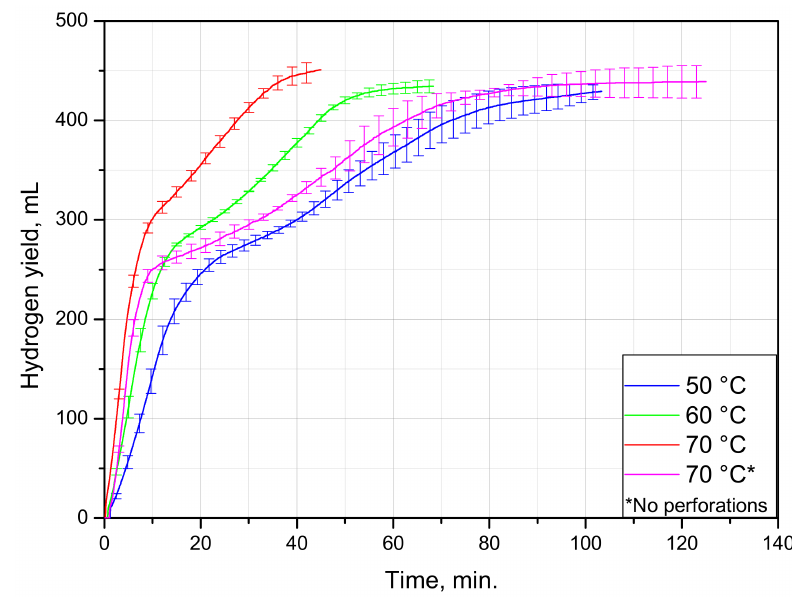
Figure 8. Kinetic curves for PET–Al–PE sheets under different temperatures.